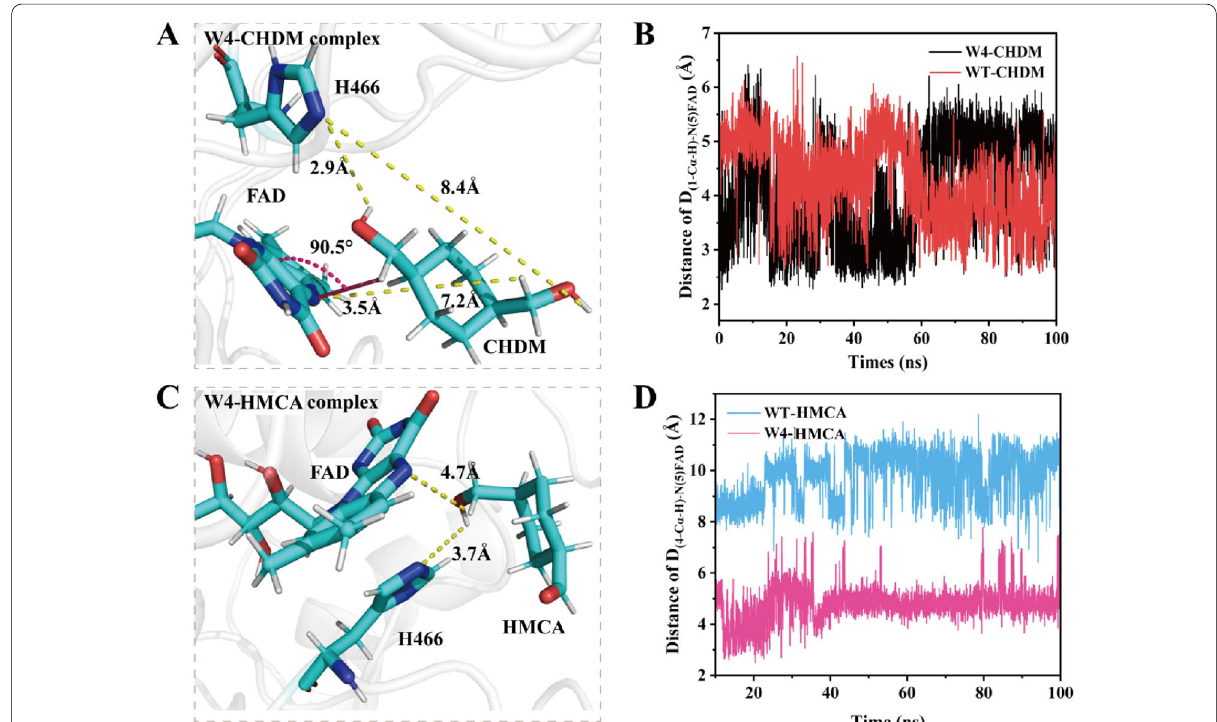
Fig. 6 Catalytically active conformation of W4-CHDM and W4-HMCA complex. A Catalytically active conformation of W4-CHDM. FAD, H466 and CHDM are shown in cyan. B Distance of hydride (H − ) transfer in WT-CHDM and W4-CHDM complex. C Catalytically active conformation of W4-HMCA. FAD, H466 and HMCA are shown in cyan. D Distance of hydride (H − ) transfer in WT-HMCA and W4-HMCA